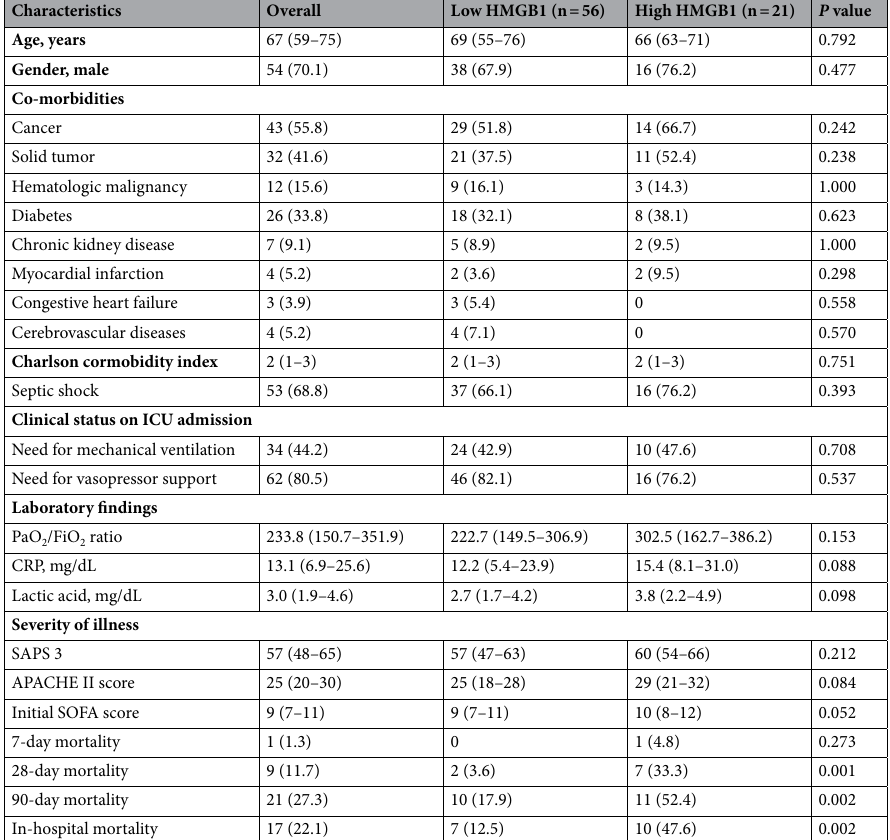
Table 3. Characteristics of patients with sepsis stratified according to the level of plasma HMGB1 from the validation cohort (n = 77). APACHE II, acute physiology and chronic health evaluation II; CRP, C-reactive protein; ICU, intensive care unit; PaO 2 /FiO 2 , arterial partial pressure of oxygen/fraction of inspired oxygen; SAPS 3, simplified acute physiology score 3; SOFA, sequential organ failure